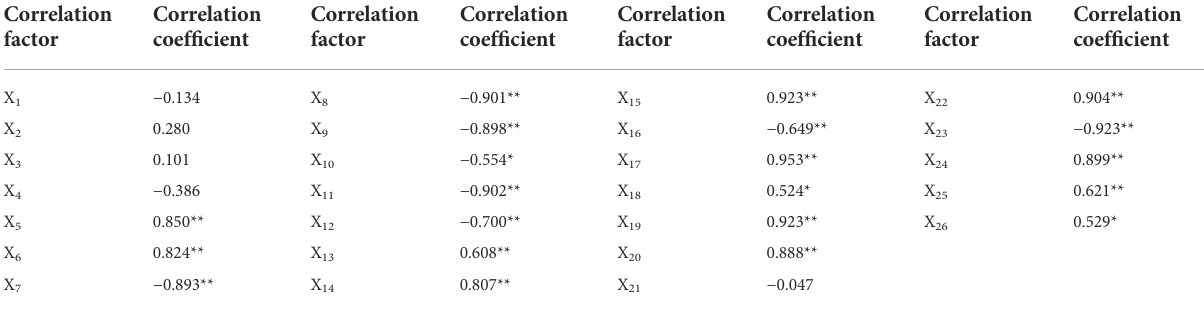
TABLE 7 Correlation coef fi cients of vulnerability of the farmland system in Sanmenxia